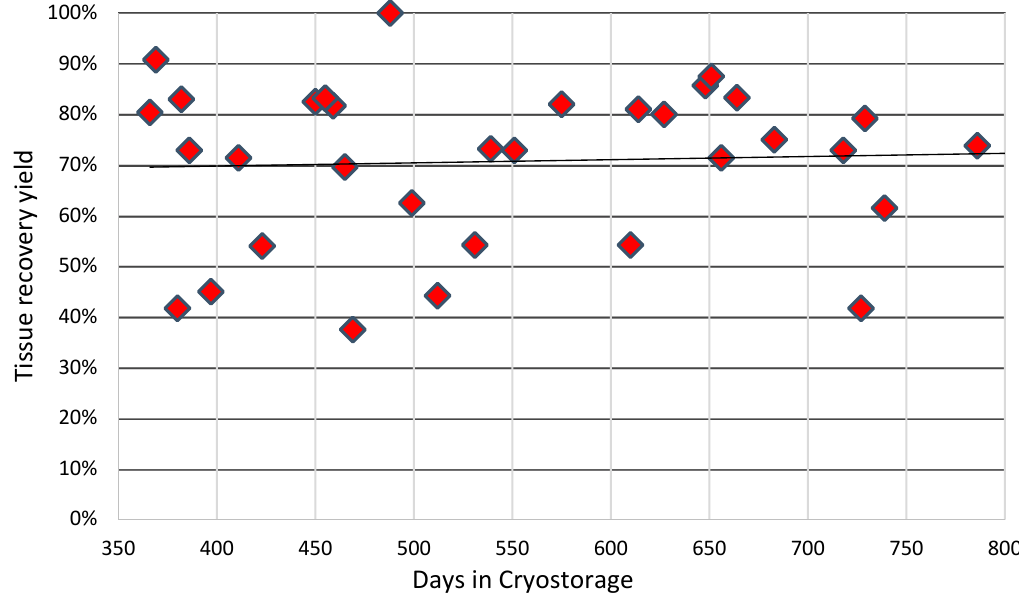
Figure 1. Long-term yield. Adipose tissue was stored for 38 patients for times longer than one year. Upon thaw an average of 71% of original tissue volume was available for subsequent use.